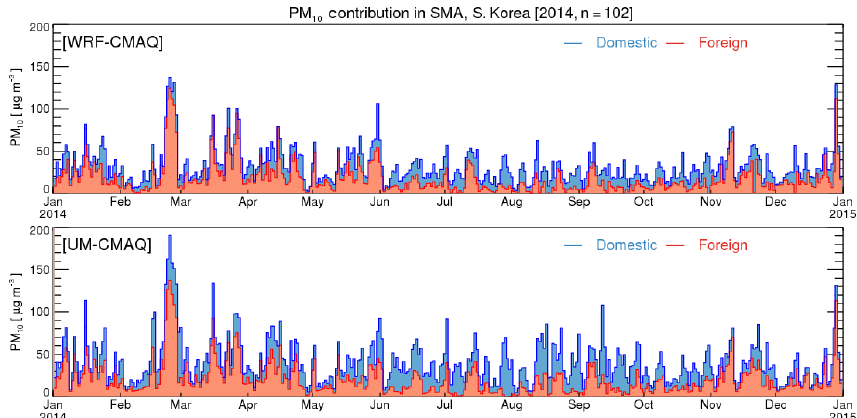
Figure 5. Time series of contributions to surface PM 10 concentrations in the SMA. Blue represents contributions from domestic emissions, while red represents contributions from foreign emissions. Contributions are calculated based on the 50% brute force reduction of South Korean